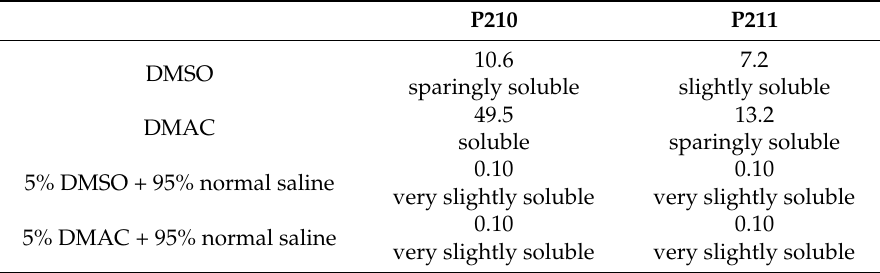
Table 1. The solubilities of P210 and P211 (in mg/1 mL).